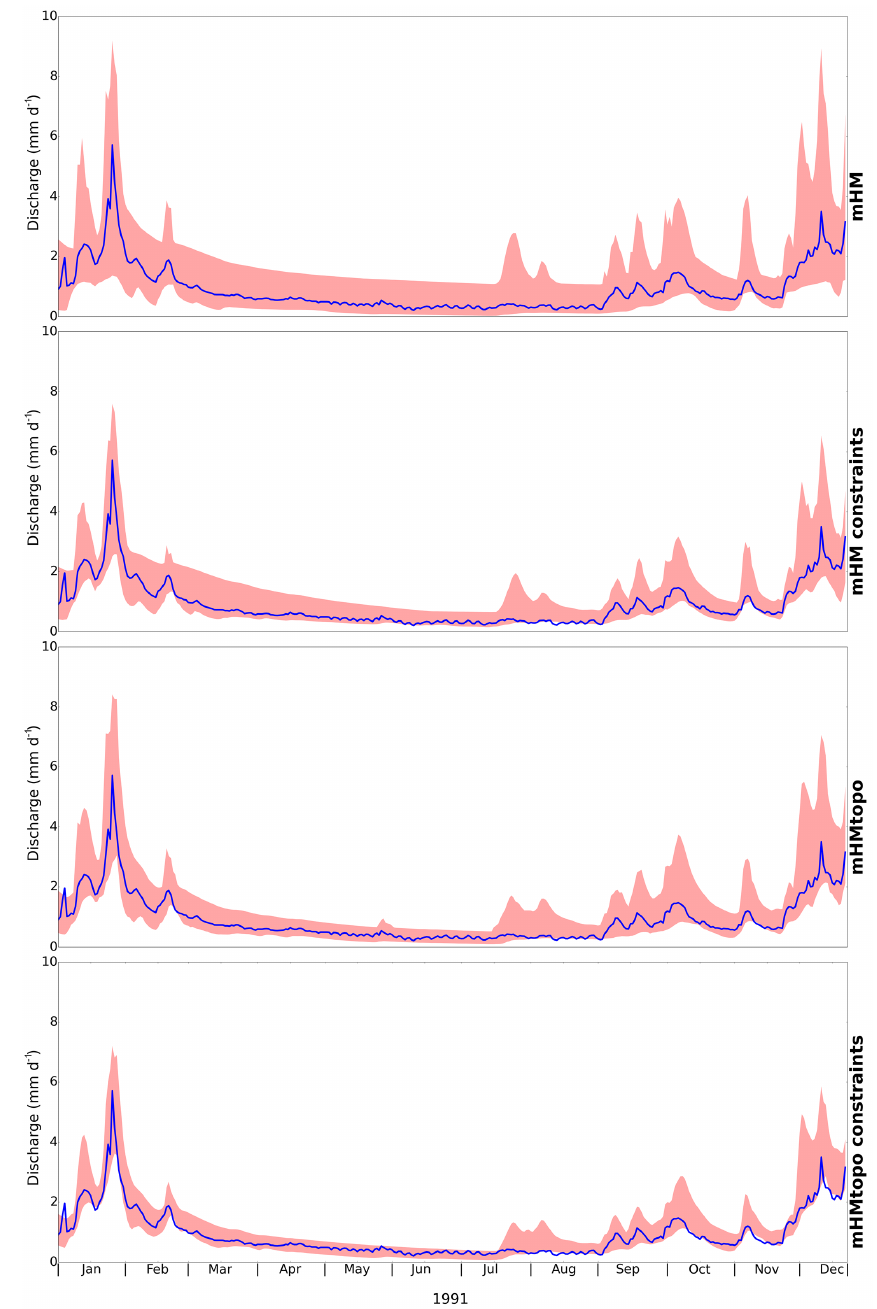
Figure 7. Hydrographs for the Treene catchment, with, respectively, the hydrographs for mHM, mHM with constraints, mHMtopo and mHMtopo with constraints. The red shaded areas represent the envelope spanned by all feasible solutions, whereas the blue line corresponds to observed